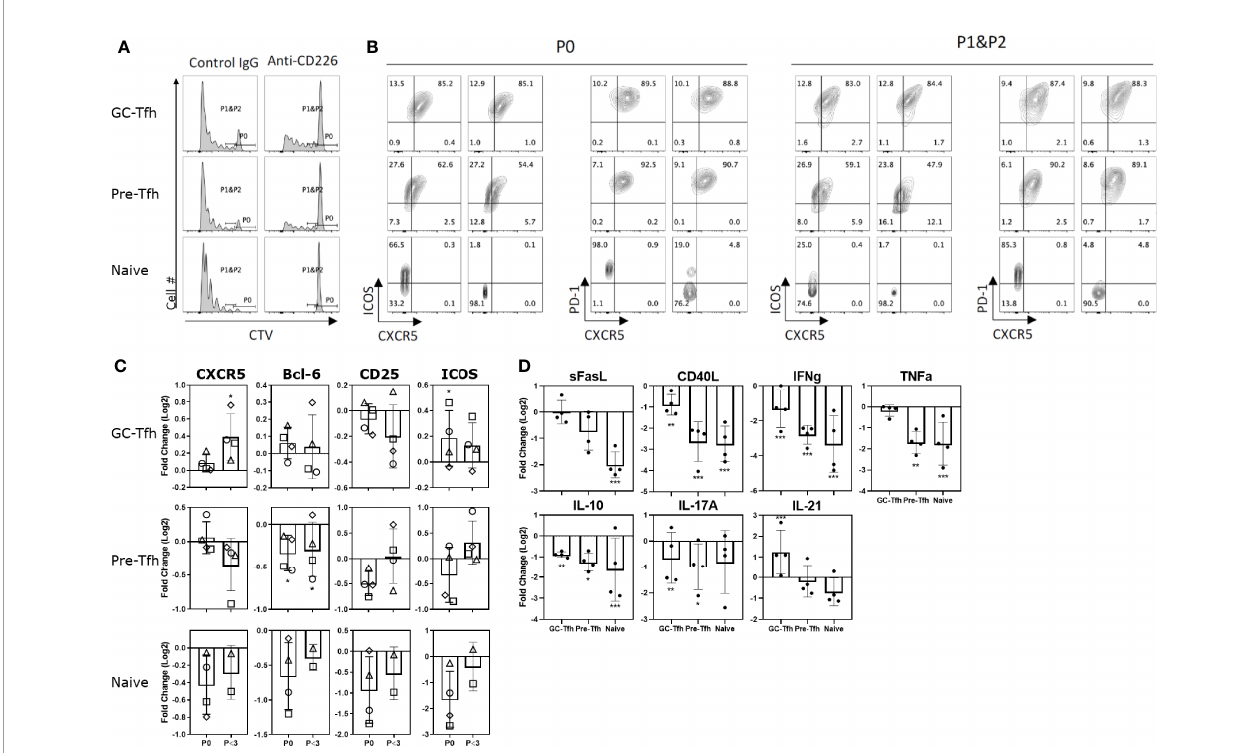
FIGURE 6 | CD155 signaling on T cells is CD226 dependent. Tonsilar GC-Tfh, pre-Tfh, and naïve cells were stimulated with CD155 + L cells coated with anti-CD3 in the presence of control IgG or anti-CD226 blocking mAb. (A) Cell proliferation assessed at day 5 by CTV dilution. Left panels – cultured with control IgG; Right panels – cultured with anti-CD226. (B) Phenotype assessed at day 5 by fl ow cytometry. Per stain each left panel was cultured with control IgG; Right panels were cultured with anti-CD226 as denoted in (A) . P0: undivided cells, P1&P2: divided cells one and two times. (C) The fold change in CXCR5, Bcl-6, CD25, and ICOS expression by anti-CD226 treatment compared to control IgG is shown in undivided (P0) and proliferated (P ≤ 3) GC-Tfh, pre-Tfh, and naïve cells. Paired t-test. l*p < 0.05; **p < 0.01. (D) The fold change in cytokine concentration by anti-CD226 treatment compared to control IgG is shown. Paired t-test. *p < 0.05; **p < 0.01; ***p <